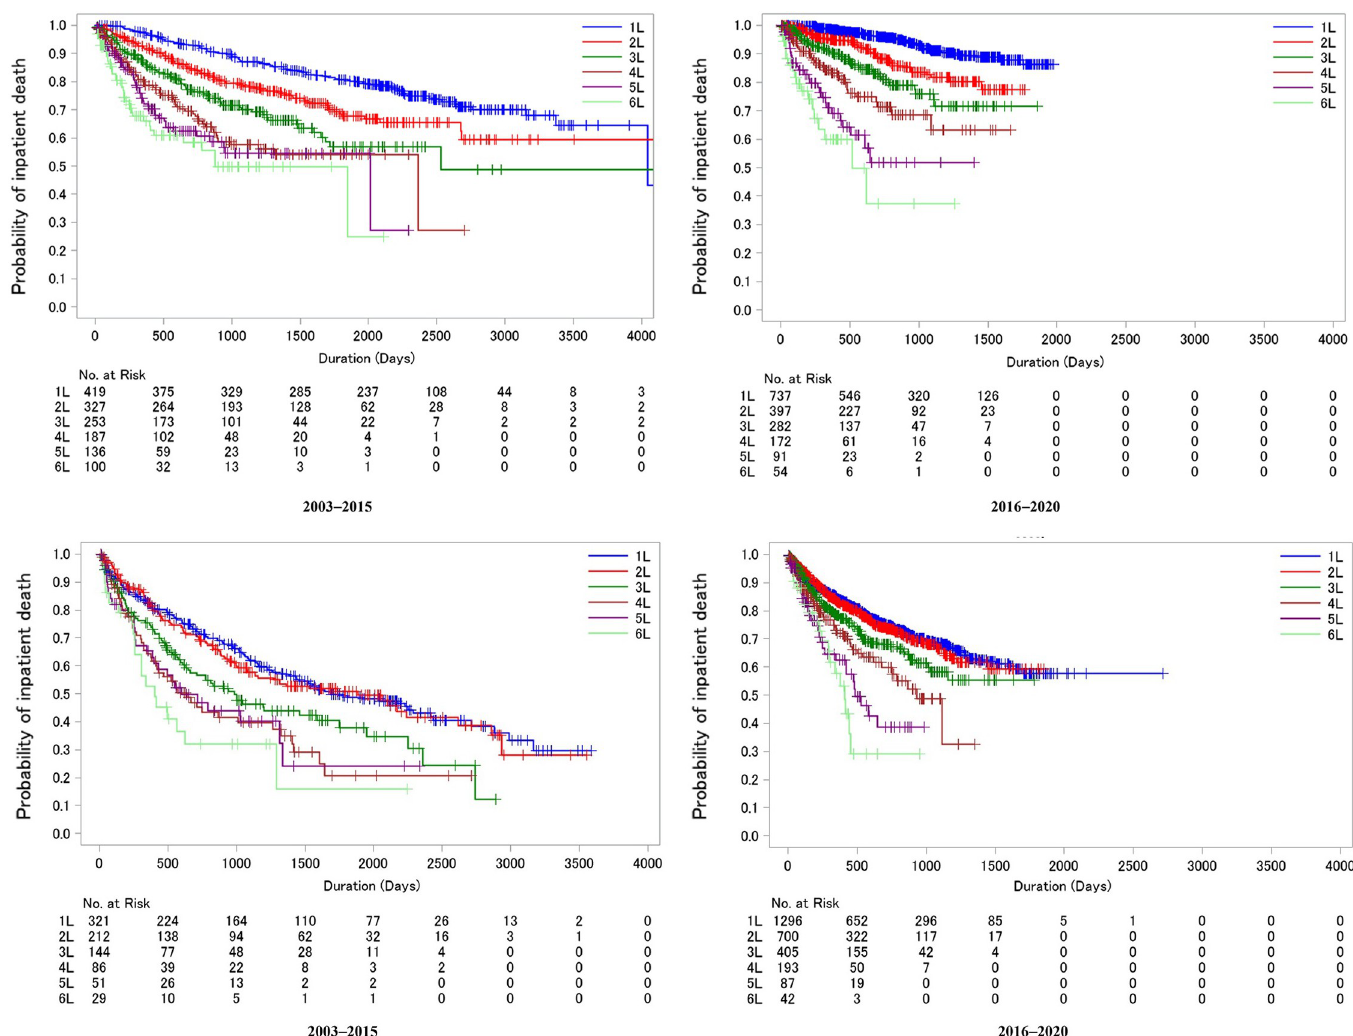
Fig 5. A . Kaplan-Meier curve for time to inpatient death by the lines of treatment for SCT-conducted group in 2003–2015 and 2016–2020 cohorts. B. Kaplan-Meier curve for time to inpatient death by the lines of treatment for SCT not-conducted group in 2003–2015 and 2016–2020 cohorts. SCT, stem cell transplantation.